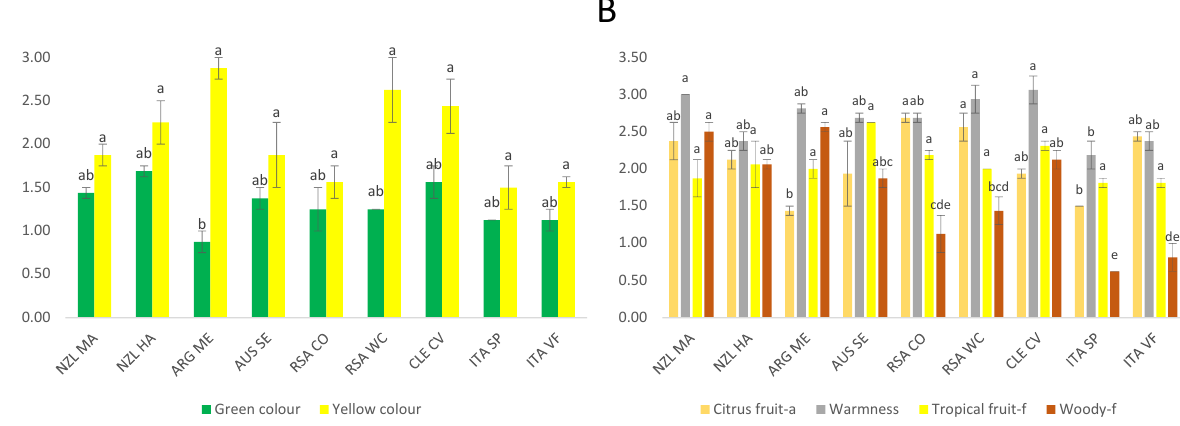
Figure 1. Significant sensory variables according to one-way ANOVA, with the Tukey HSD results. The coloured bars indicate the average between the two duplicates for the different sensory attributes also reporting the standard deviations. ( A ) Significantly different colour attributes, ( B ) Significantly different aroma, taste, and flavour attributes. Letters a–e indicate the groupings found with Tukey’s post-hoc